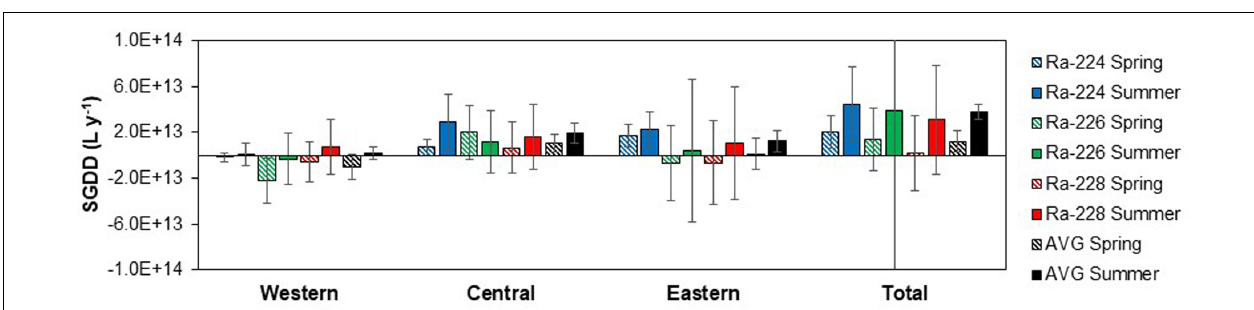
FIGURE 4 | Summary of 224 Ra (top), 226 Ra (middle), and 228 Ra (bottom) sources and sinks to Long Island Sound, arranged by basin and season. A negative SGD flux implies either that Ra sources approximately balance Ra sinks (within the propagated uncertainties), or that one (or more) known Ra flux is improperly characterized.